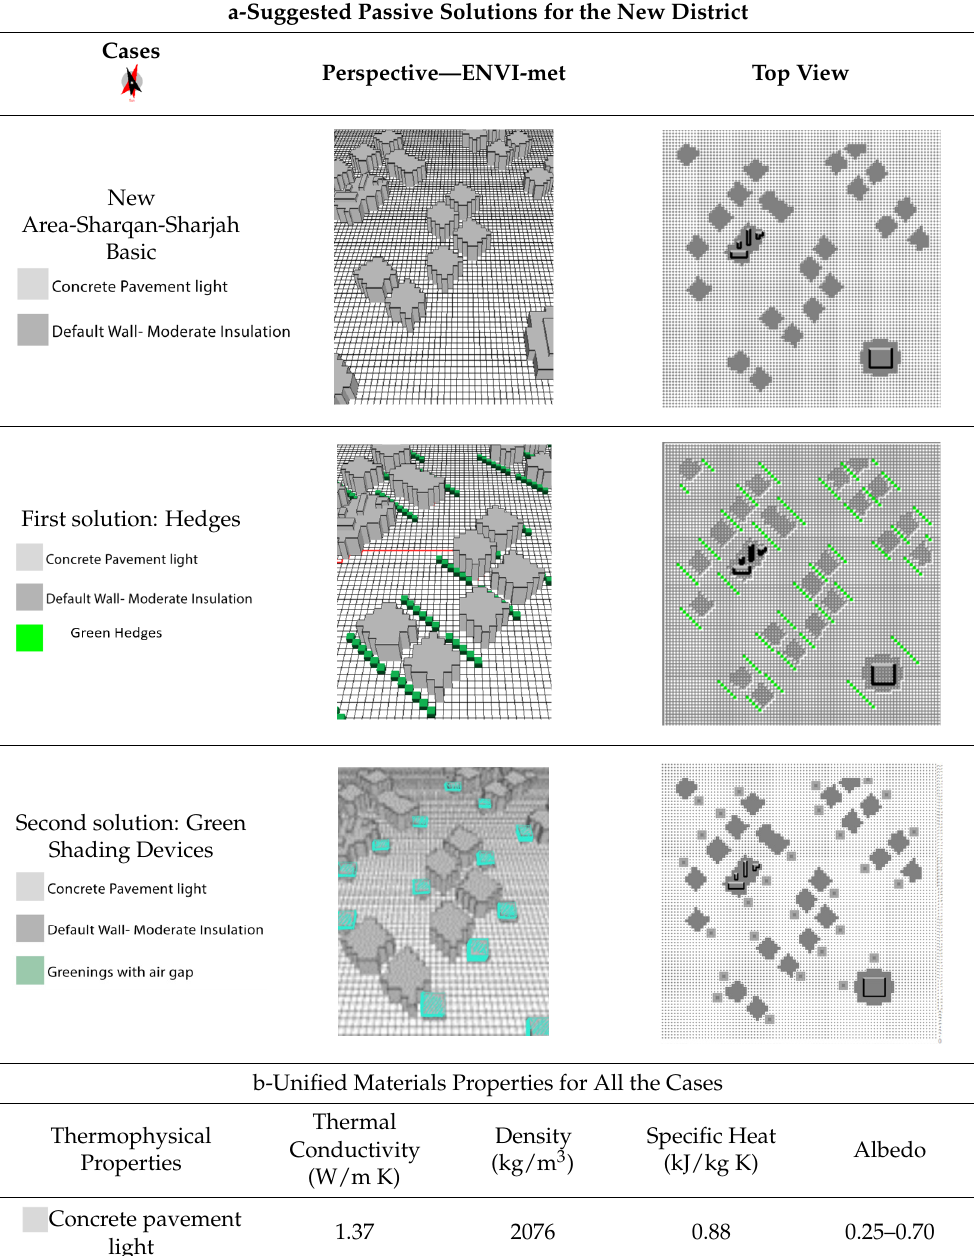
Table 5. The suggested passive solutions with the unified materials properties for the new district.